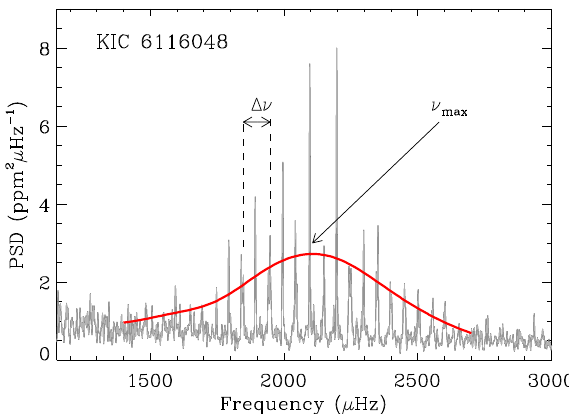
Fig. 40 The oscillation power spectrum of the star KIC 6116048 computed with Kepler data obtained over a period of 1month. The red line is the envelope of power obtained by heavily smoothing the power spectrum. The envelope has been multiplied by a factor of 5 to make it more visible. (Image courtesy of William J.